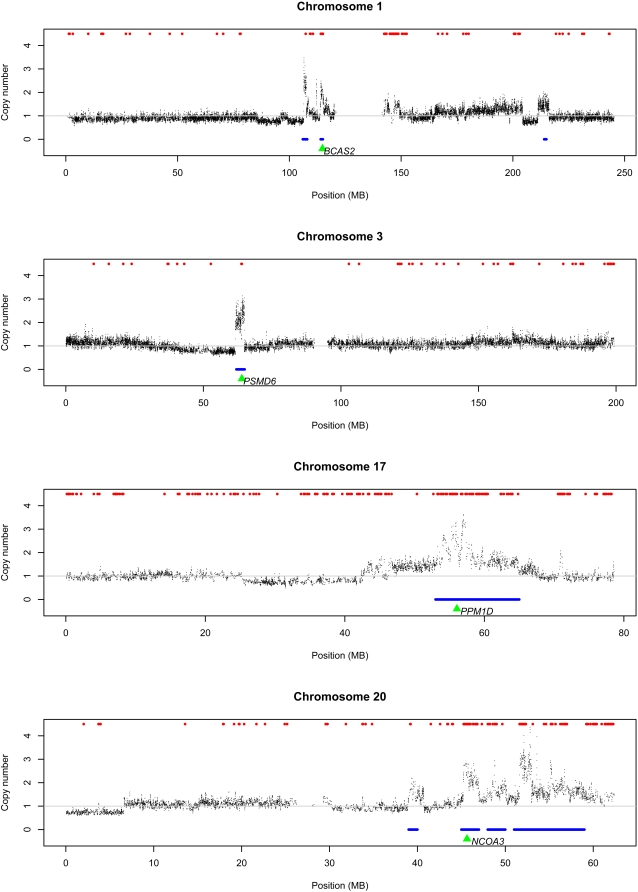
Chromosome-wide plots for copy number distribution.Four representative chromosomes (1, 3, 17 and 20) are shown in this figure. See Figure S2 for the same plots for all chromosomes. Red and blue bars at the top and bottom in each plot designate actively transcribed and high copy number regions, respectively. Green triangles represent location of the BCAS2 (chromosome 1), PSMD6 (chromosome 3) , PPM1D (chromosome 17) and NCOA3 (chromosome 20) gene loci, respectively.